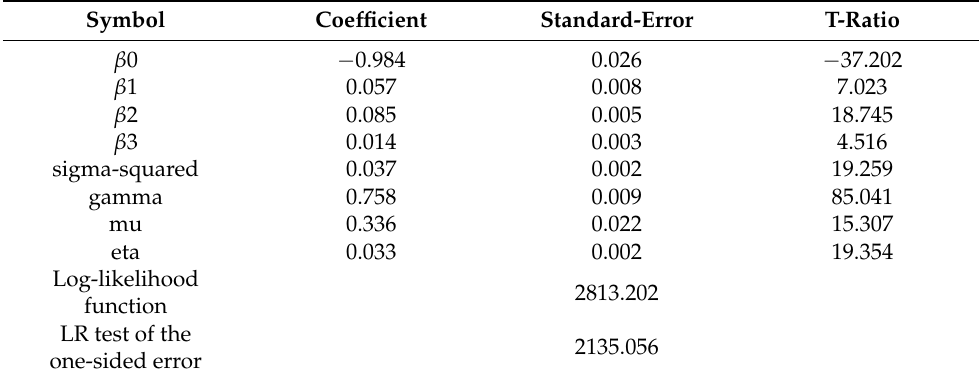
Table 3. Estimation results of stochastic frontier equation.